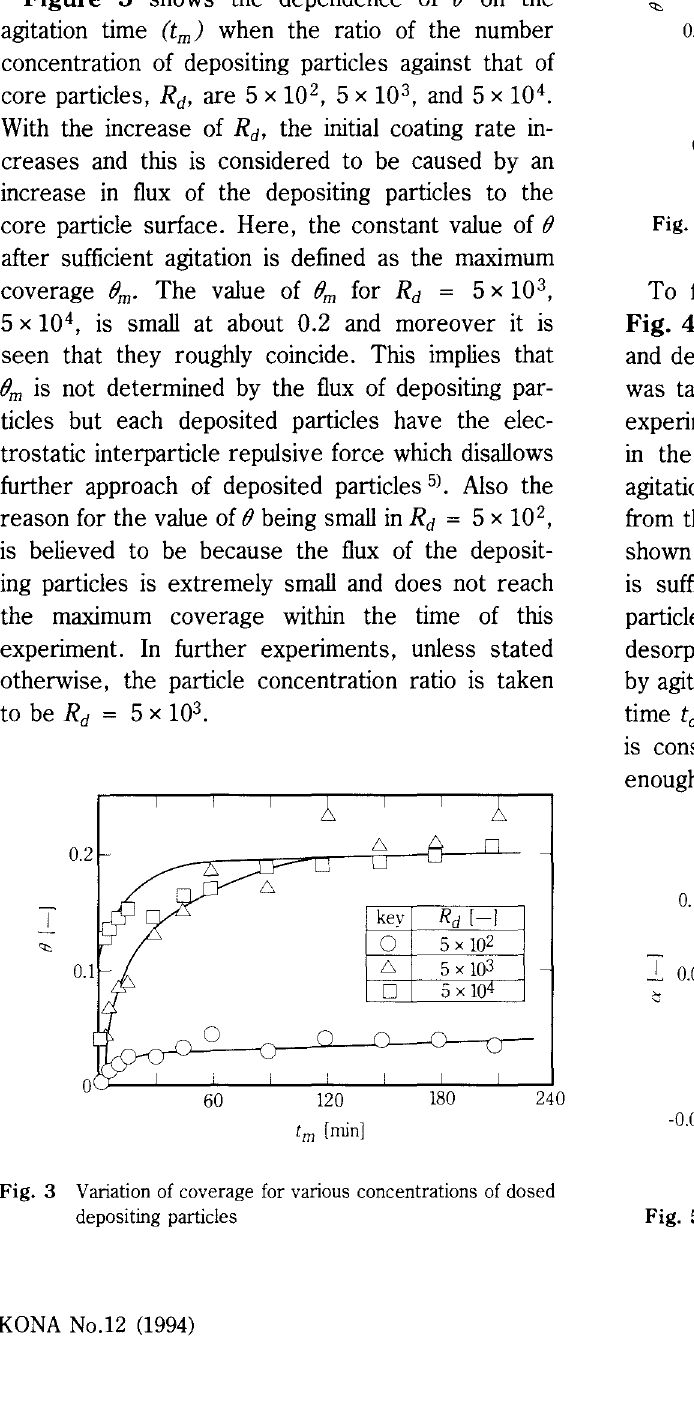
Fig. 3 Variation of coverage for various concentrations of dosed depositing particles